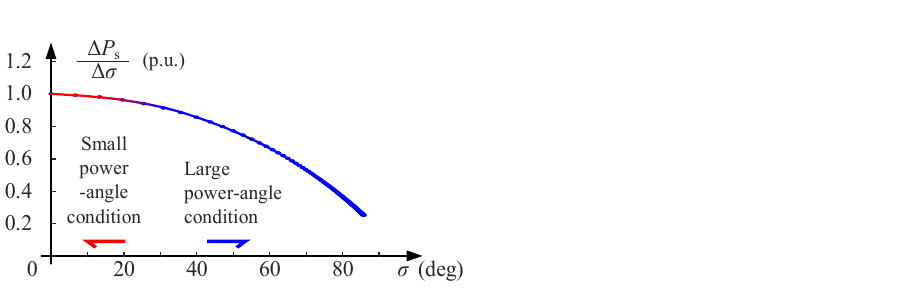
Figure 3. Active power regulation per unit power angle for different power-angle conditions.